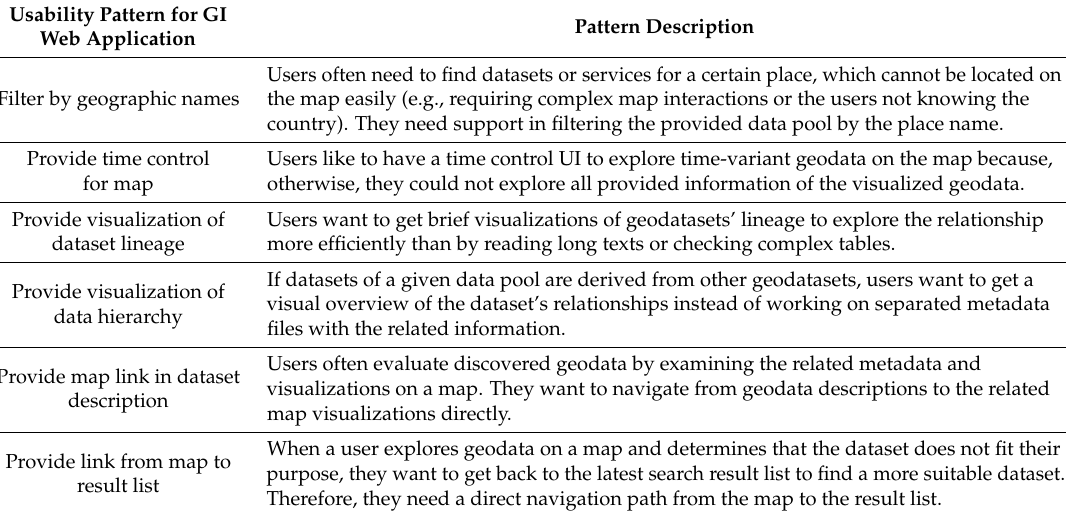
Table 2. Usability pattern examples. GI—geoinformation; UI—user interface. Usability Pattern for GI Web